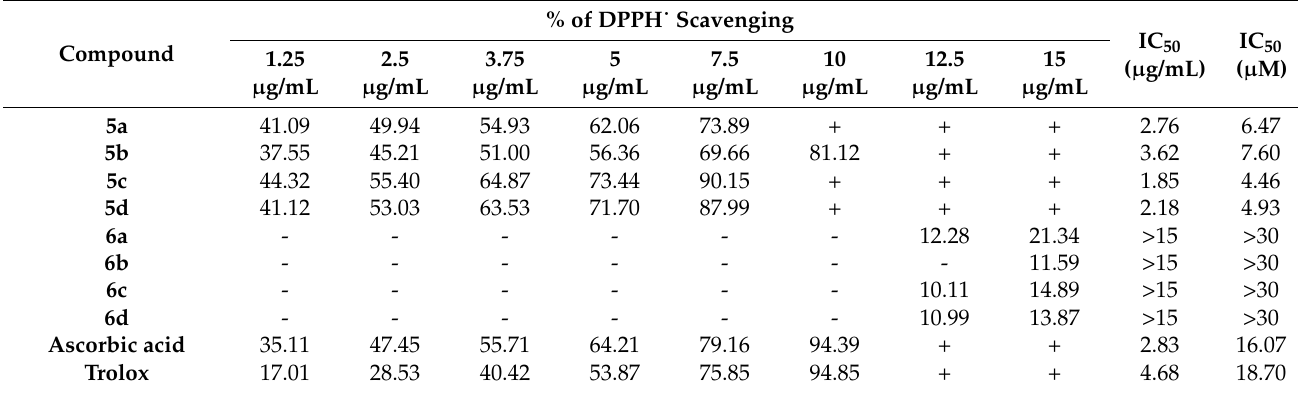
Table 2. Results of the DPPH ˙ scavenging assay.